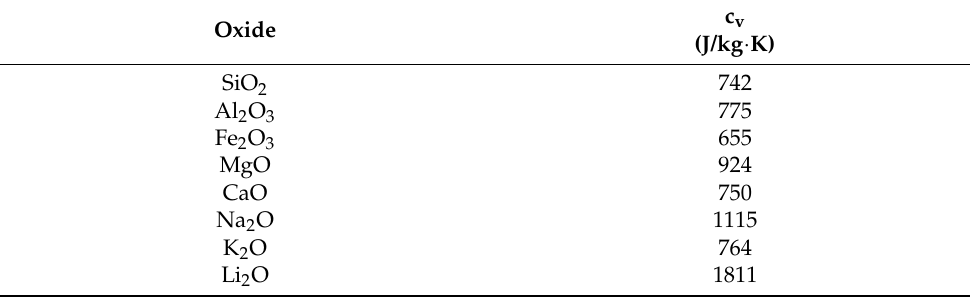
Table 2. Specific heat of oxides in the raw materials.